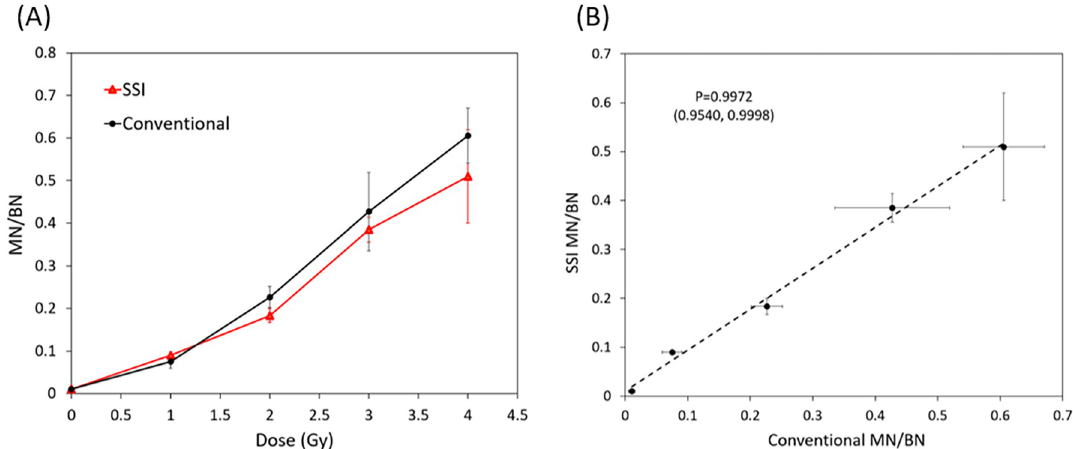
Fig 7. (A) CBMN dose curves by SSI and conventional process showing strong dose-dependent MN/BN ratios. (B) Pearson’s correlation analysis showing a strong positive correlation between the SSI and the conventional control samples with a coefficient P = 0.9972 and 95% confidence interval (0.9540, 0.9998).